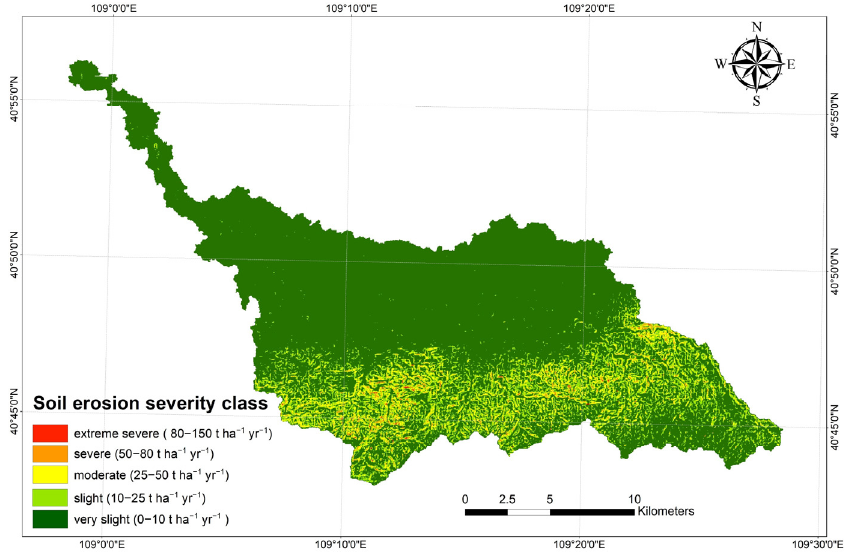
Figure 4. Soil erosion severity level of